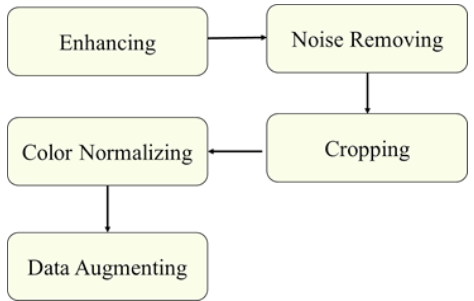
Figure 6. The retina images preprocessing methods.